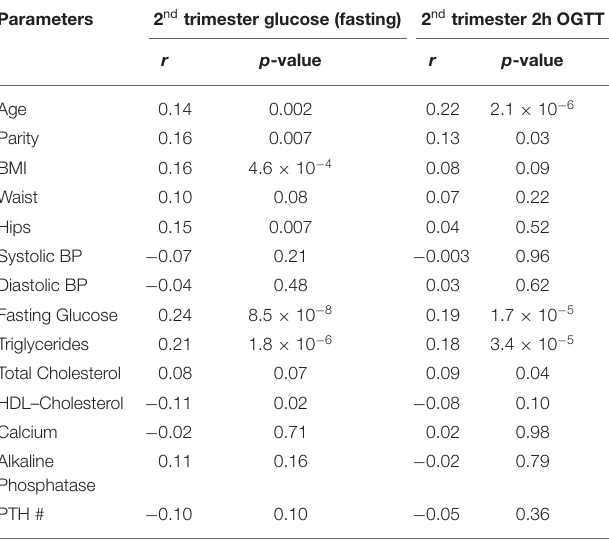
Data presented as correlation coefficient (r) and the associated p-value. Pearson correlation is used for normal variables and Spearman correlation for non-normal variables (#).